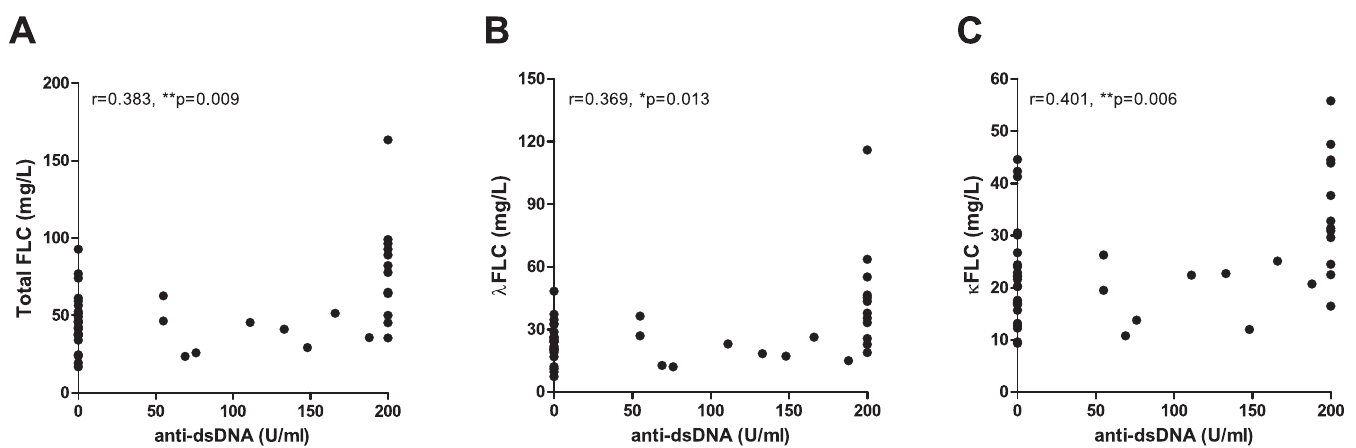
Fig 3. Correlation between serum FLC concentrations and anti-dsDNA titer. Correlation between anti-dsDNA titer (U/ml) and total FLC (A), λ FLC (B) and κ FLC (C) levels in SLE patients (n = 45). r-values are 0.383 (p = 0.009), 0.369 (p = 0.013) and 0.401 (p = 0.006) in A, B and C, respectively. FLCs — free light chains, SLE — systemic lupus erythematosus, dsDNA — double stranded DNA.